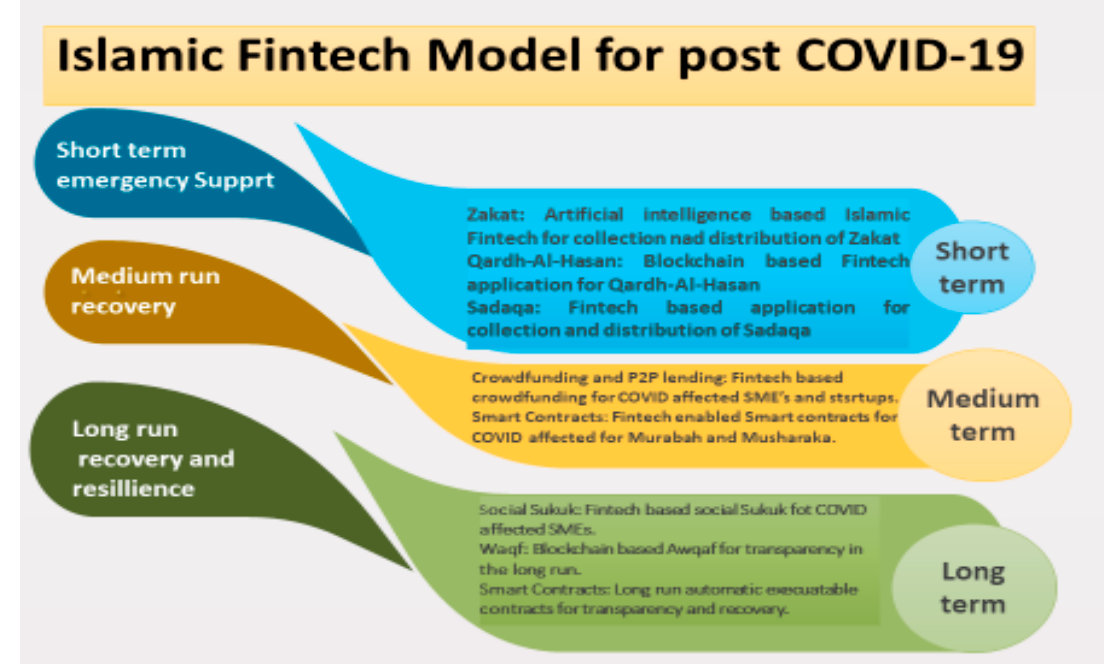
Figure 5. 3-stage Islamic Fintech for post COVID-19. Source: Author’s own compilation.